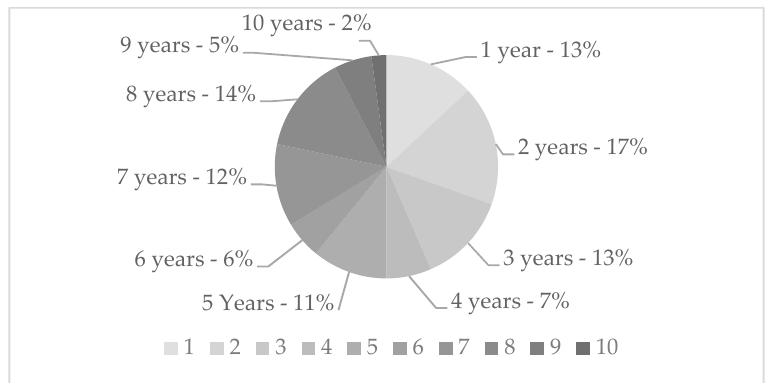
Figure 1. Years of experience in estimating the cost of earthquake damage repair work.